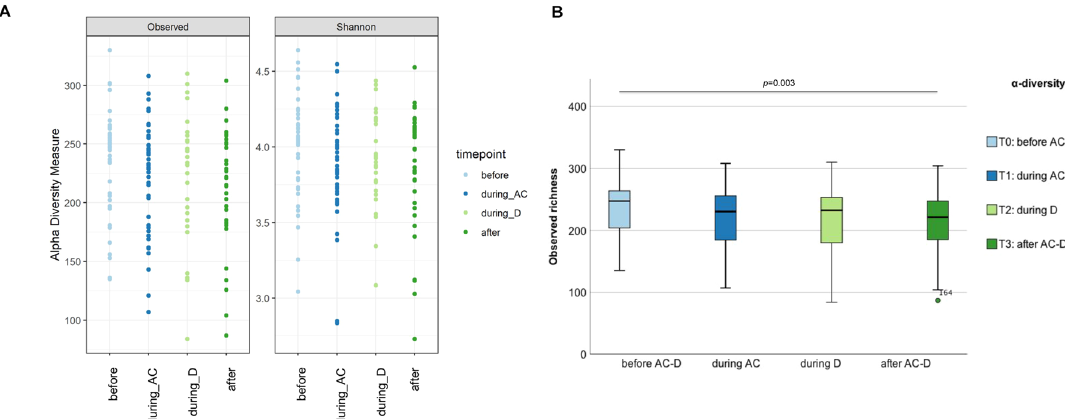
Fig. 3 Microbiota diversity before, during and after chemotherapy. A Changes in α -diversity measures of the 28 participants who provided all four samples before AC-D, during AC, during D and after AC-D treatment, measured in terms of observed species richness ( p = 0.042; n = 28) and Shannon index ( p = 0.206; n = 28) (Supplementary Table 5). B Pairwise comparison (Wilcoxon signed-rank sum test with Bonferroni correction) of all samples before AC-D ( n = 44), during AC ( n = 43), during D ( n = 29) and after AC-D treatment ( n = 37) revealed signi fi cant differences in observed species richness between T0-T3 ( p = 0.003; n = 37) (Supplementary Table 6). The boxplot in Fig. 3B shows the medians, IQR ’ s, minimum, maximum and an